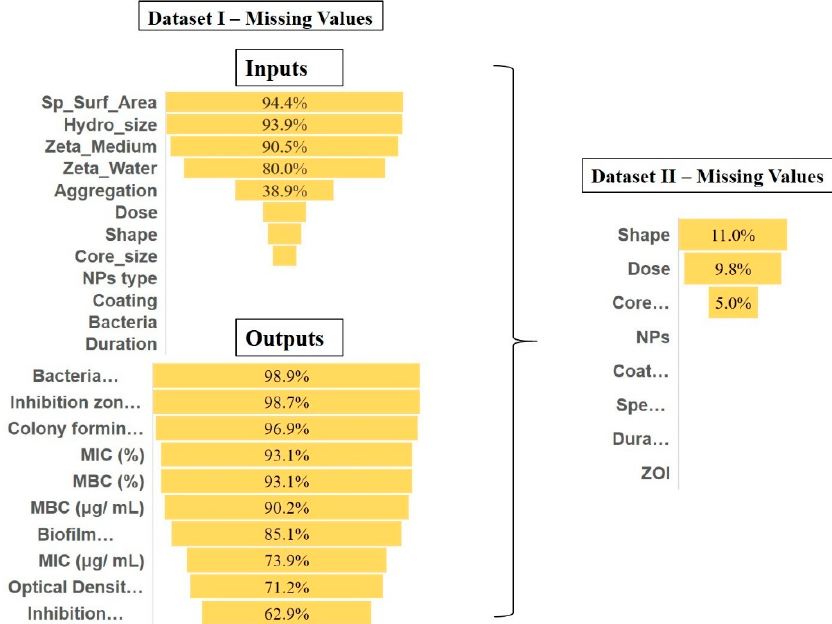
Figure 2. Dataset I. Missing values (percentages) of input and output parameters (left). Dataset II missing values of inputs and one outcome, ZOI (right).